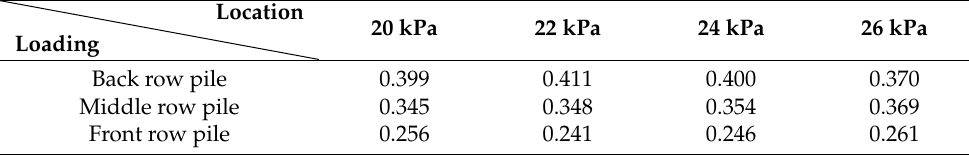
Table 4. The earth pressure sharing ratio of each row of piles (static model